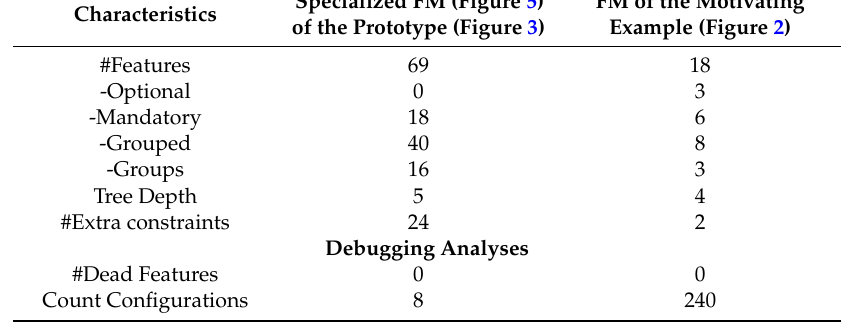
Table 2. Basic metrics of the SC feature model taken from the tool SPLOT.